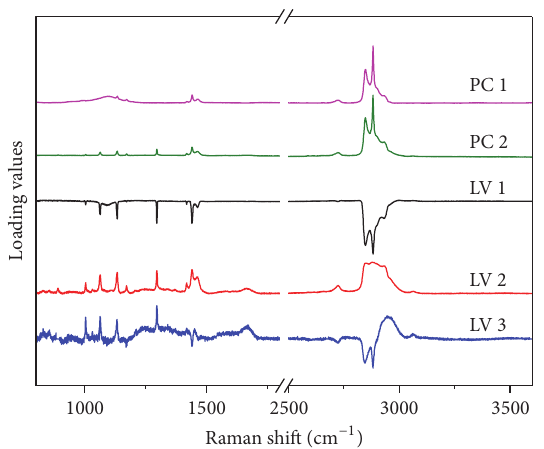
Figure 3: Loading plot of PCA components (PC) and PLS compo- nents (LV) in the each model calculated from the Raman spectra of colorectal tissues. Each loading is shifted vertically for better visualization. The broken interval (-//-) indicates the region of ∼ 2000–2500 cm −1 , which does not contain much tissue-related biochemical